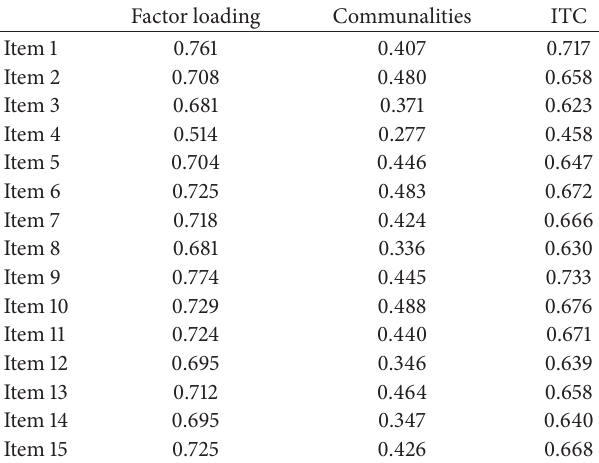
Table 2: Factor loadings after the exploratory factor analysis and the corrected item-total correlation of the CD-Quest.